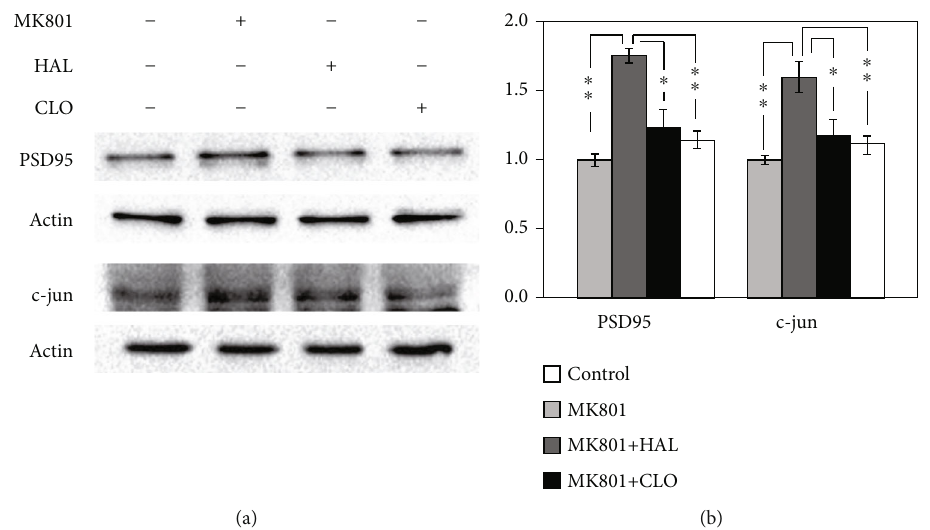
Figure 6: E ff ects of MK801, haloperidol (HAL), and clozapine (CLO) on PSD95 and c-jun regulation in B35 cells. (a) Western blot revealing APD-induced changes in the expression of PSD-95 and c-jun proteins in B35 cells. (b) Protein expression was quanti fi ed and normalized to beta-actin, and the relative expression of each protein in the bar chart was calculated from triplicate western blot data obtained from three di ff erent batches of APD-treated cells and analyzed using ANOVA followed by Dunnett ’ s test ( ∗ p value < 0.05; ∗∗ p value <